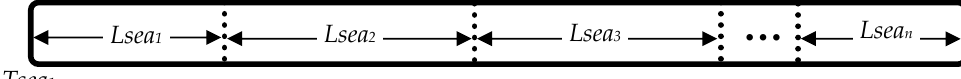
Figure. 2. Season definition. Figure 2. Season